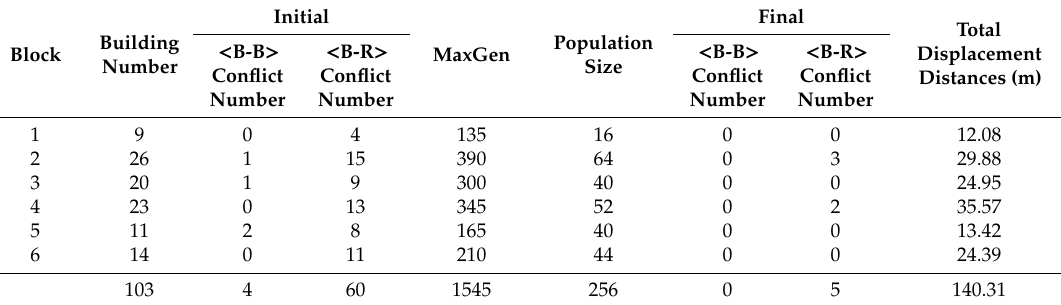
Figure 6. Comparison diagram. ( a ) Displacement result using the GA (1:10,000); ( b ) Comparison result of the original data and displacement results based on the GA (1:10,000). Table 3. Statistical information of the displacement results based on the